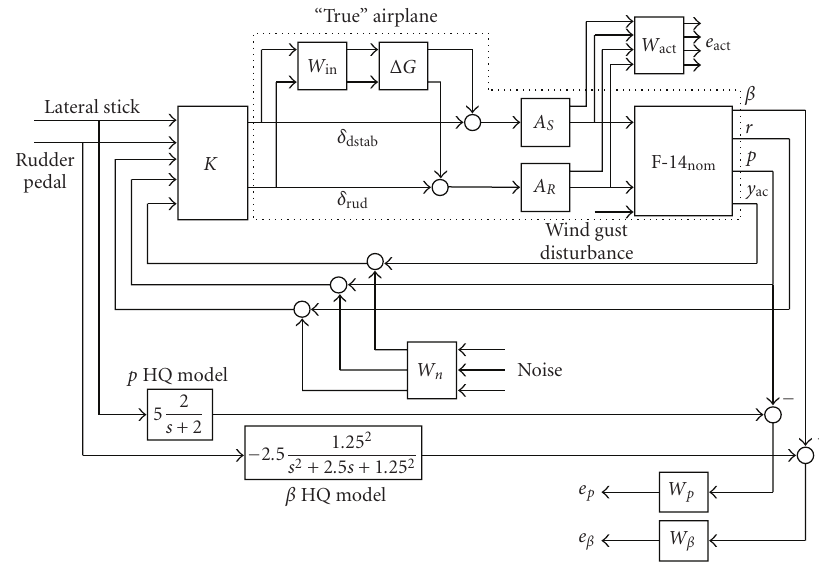
Figure 4: Control design diagram for F-14 lateral axis (Courtesy of The MathWorks,